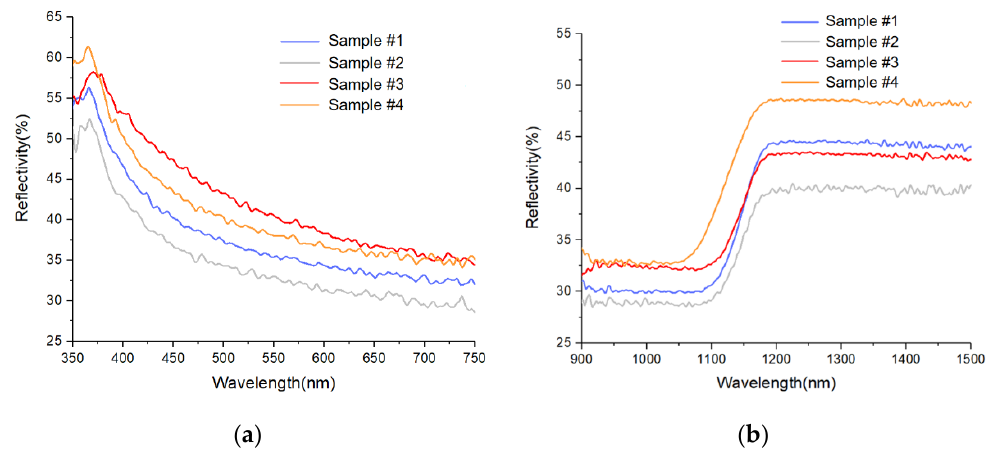
Figure 8. Reflectivity test results: ( a ) Visible-light waveband; ( b ) infrared (IR) band.